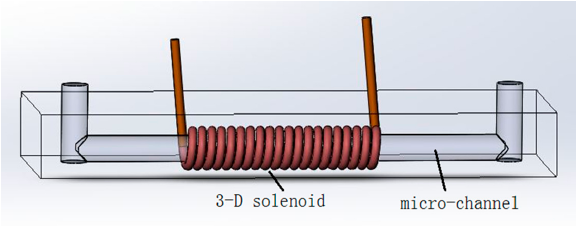
Figure 1. Design of the micro inductive sensor for hydraulic oil detection: the diameters of the solenoid coil and the micro-channel are 25 μ m and 300 μ m, respectively.